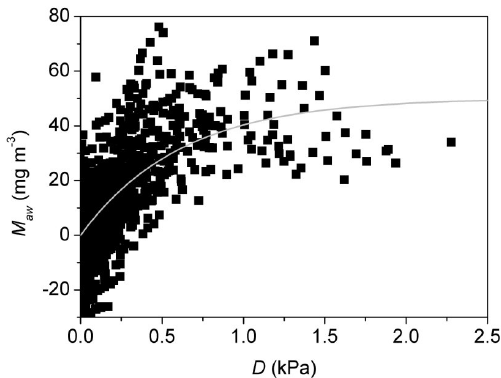
Fig. 8. Relationship between the concentration of methanol ( M aw ) in the water films and the vapour pressure deficit ( D ) for July- August-September 2009. The negative value is due to the modeled uncertainty of M aw ( ± 20 mg m 3 ) .